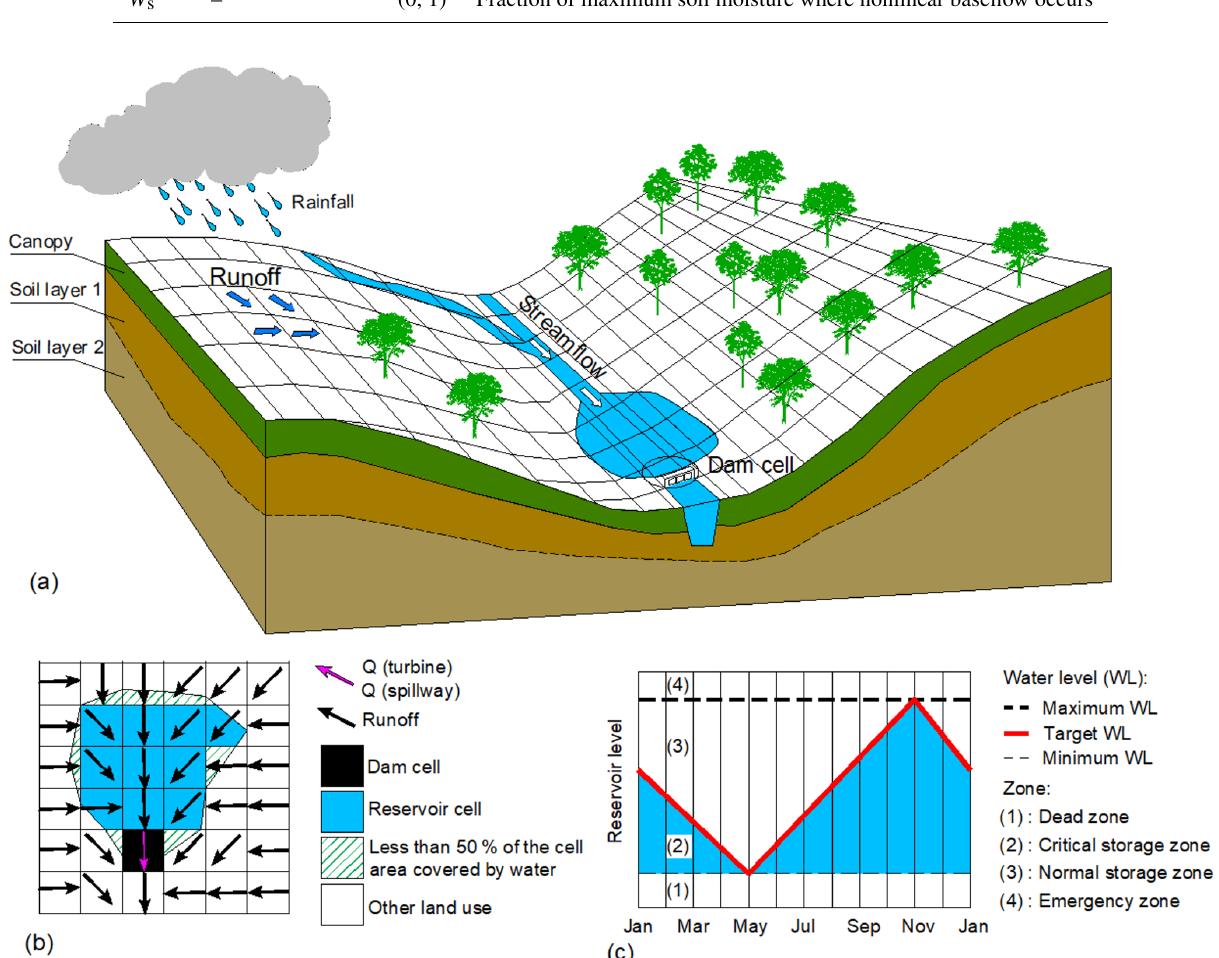
Figure 3. Graphical representation of VIC’s spatial domain (adapted from http://www.hydro.washington.edu, last access: 22 January 2020) (a) , including the selection of dam cell (black), reservoir cells (blue), and cells with other land use (white and white with green lines). The black and pink arrows indicate the direction of the flow routing and discharge from the reservoir (b) . Seasonal rule curve (c)